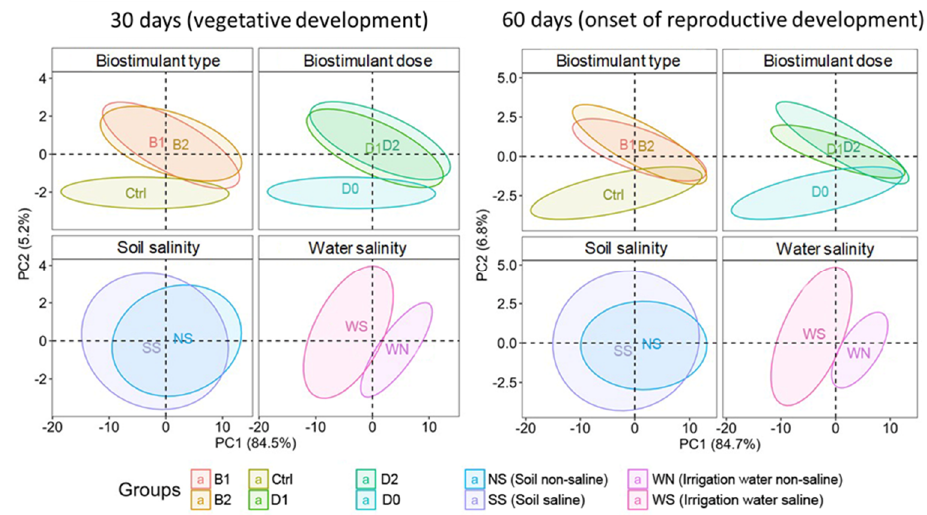
Figure 1. Principal component analysis (PCA). An interaction graph of the four experimental factors studied at 30 days in the vegetative developmental stage ( left ) and at 60 days, at the beginning of reproductive development ( right ), in Solanum lycopersicum plants. The factors studied were: Biostimulant type [Ctrl: control; B1: biostimulant with polyphenols at 1.4% ( w / w ) and glycine betaine at 3.0% ( w / w ); B2: biostimulant with polyphenols at 1.4% ( w / w ) and glycine betaine at 5.0% ( w / w